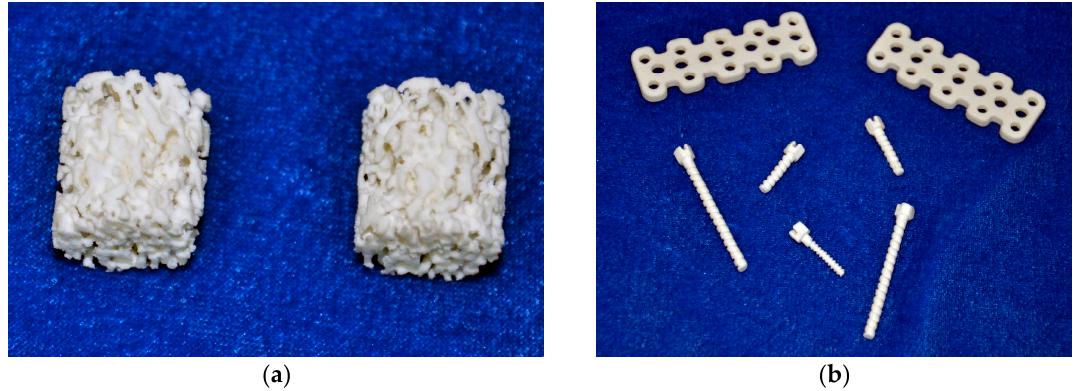
Figure 3. Hydroxyapatite/collagen composite’s application in repairing of bone defects. ( a ) Bone scaffolds of the hydroxyapatite/collagen composite; ( b ) Bone nails and bone plates of the hydroxyapatite/collagen composite.